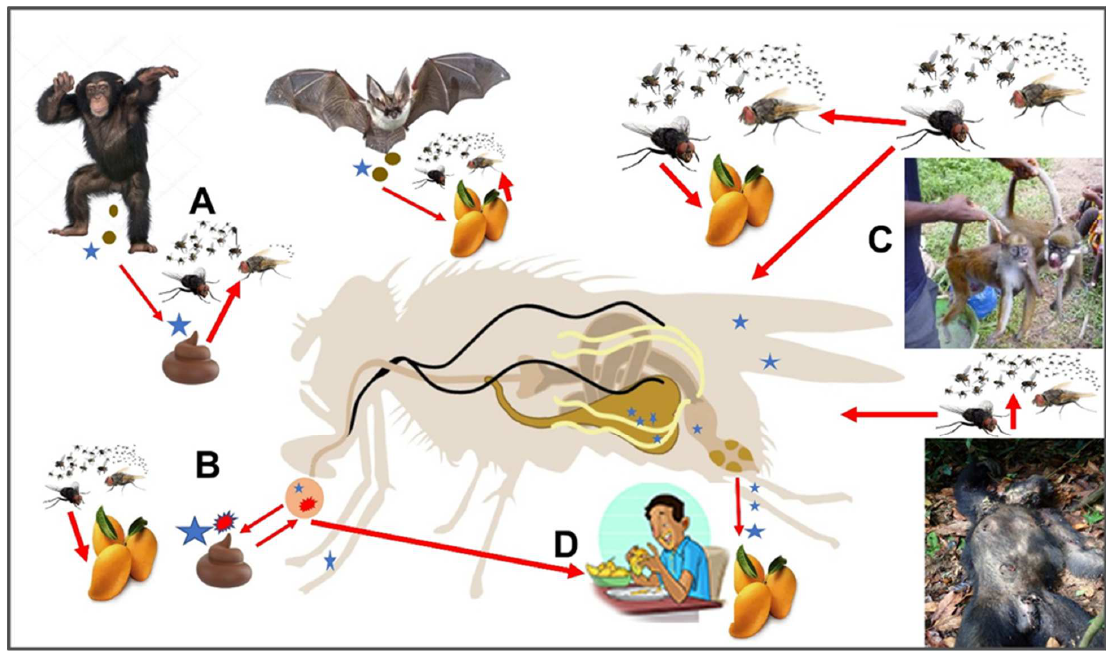
Figure 5. The fly image is the courtesy of Dana Nayduch and is modified from Nayduch and Burrus, [29], 2017, while the dead chimpanzee photo is the courtesy of Jennifer Jaffee and the Tai Chimpan- mango eater by Sahil